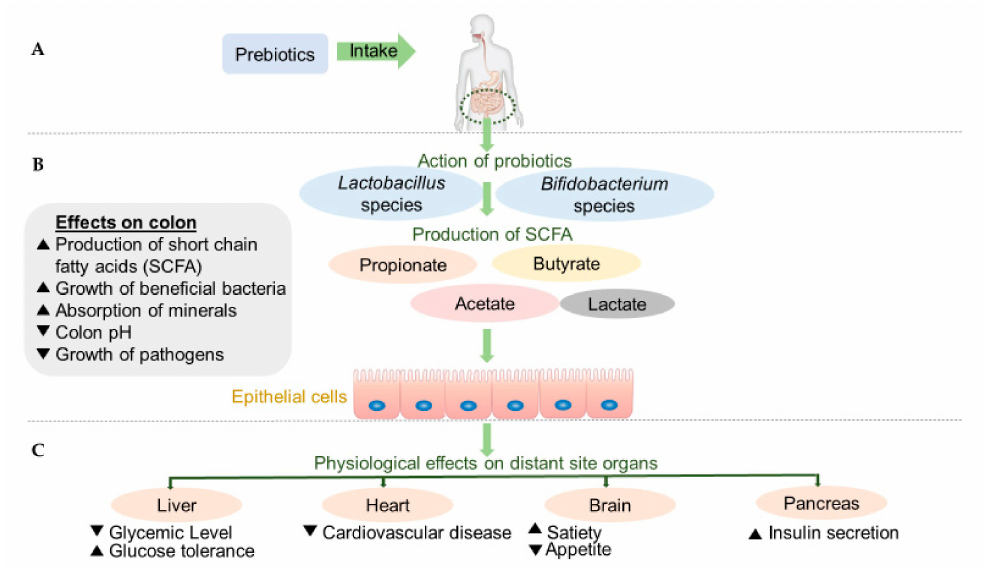
Figure 1. Effect of prebiotics on human health. ( A ) Consumption of prebiotics, ( B ) Direct effects of prebiotics on colon, ( C ) Indirect effects of prebiotics on other organs. Corresponding symbols (cid:78) and (cid:72) stand for “increase” and “decrease”, respectively. Based on Farias et al.